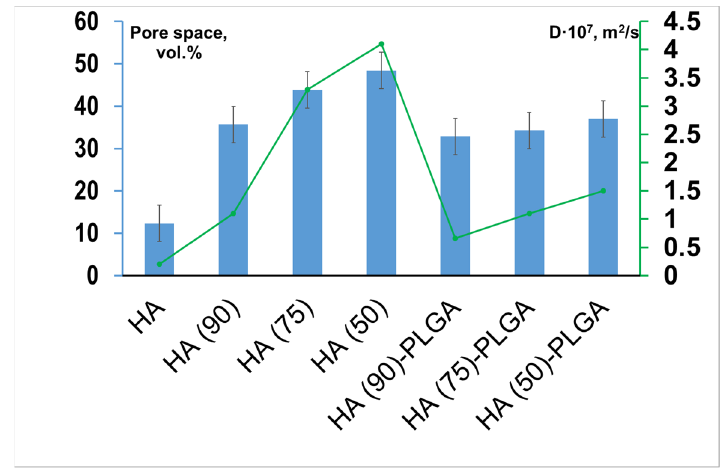
Figure 9. Open porosity of materials before and after impregnation with PLGA (vol.%) and values of the diffusion coefficient D (m 2 /s) for materials HA (90)-PLGA–HA (50)-PLGA and initial porous HA frameworks.